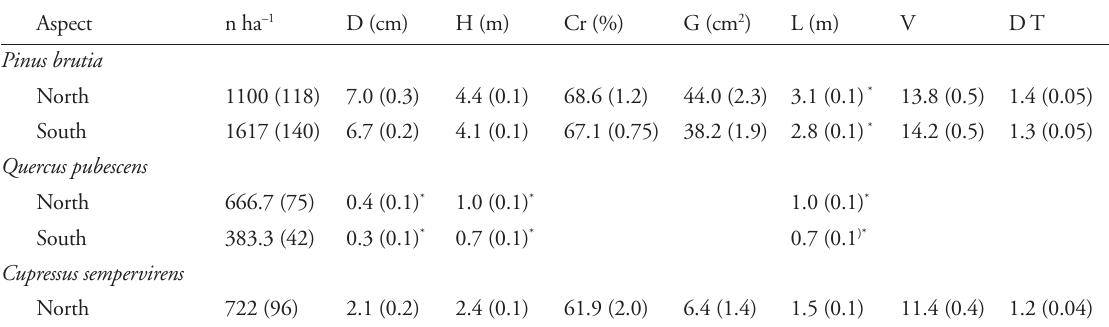
Table 1. Structural data for naturally regenerated Pinus brutia and planted Quercus pubescens and Cupressus sempervirens individuals in the mixed stands on northern and southern aspects. Values in brackets represent SE; * significant differences (p < 0.05) between the two aspects; D (cm): express the DBH for trees and D (at root collar) for seedlings and saplings.